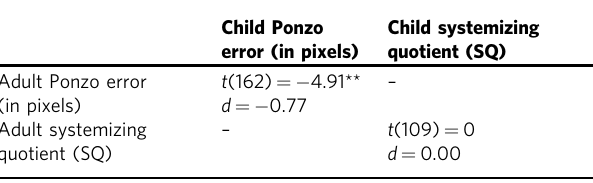
Table 4 Independent samples t -test across age-category and